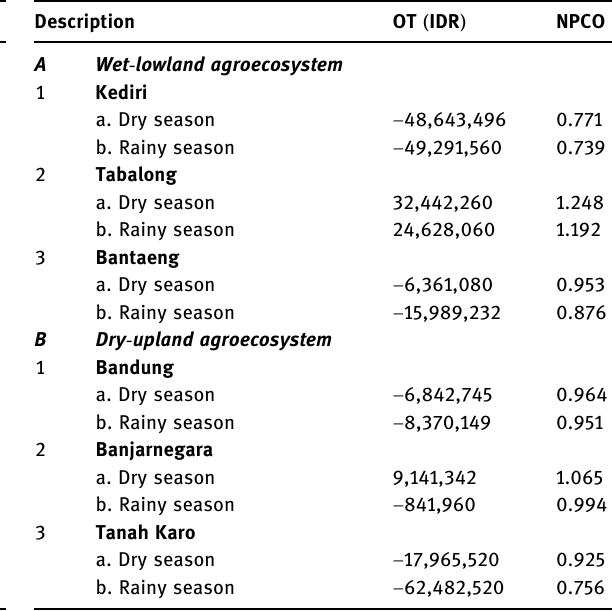
Table 3: PCR and DRCR coe ffi cient values of chili farming in research locations, dry season of 2019 and rainy season of Table 4: OT and NPCO values of chili farming in research